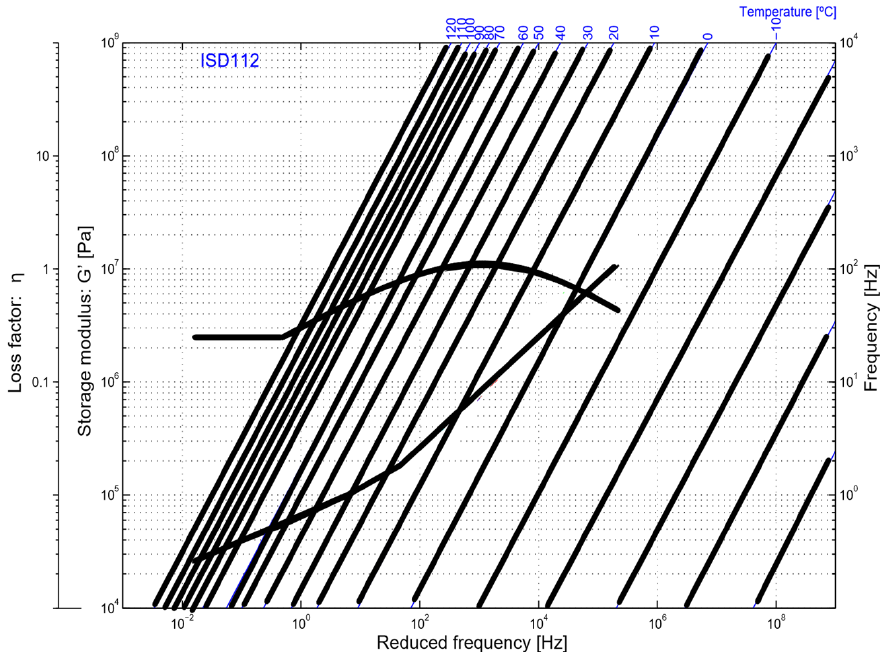
Figure 13. Frequency nomograph used to determine the storage modulus and loss factor in the vis-